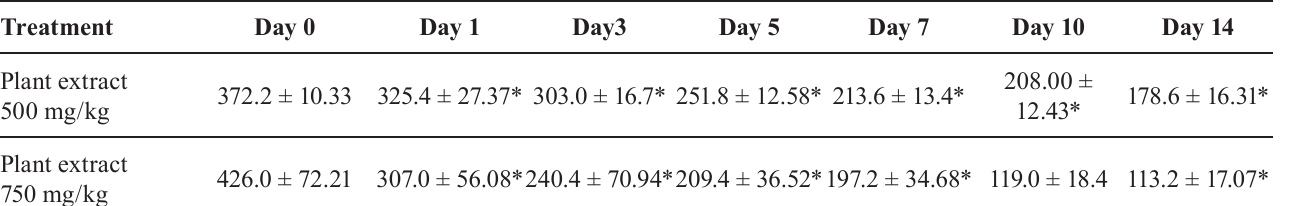
TABLE II – Fasting blood glucose level (mg/dL) in diabetic rats exposed to M. neglecta extracts